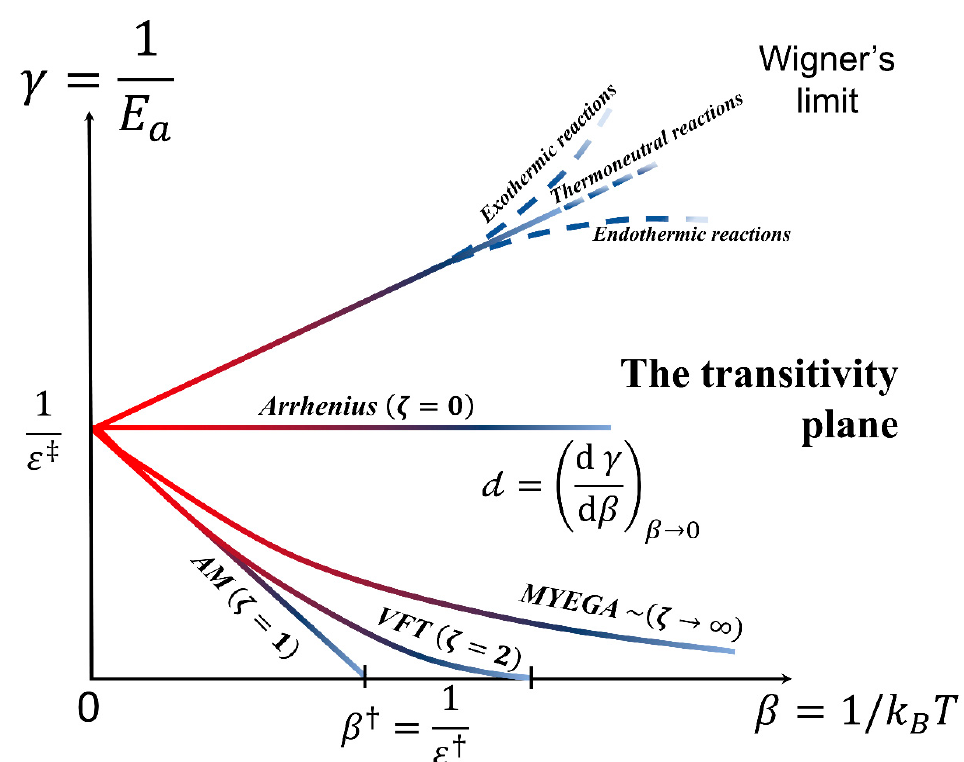
Figure 5. The alpha-zeta totem. The transitivity plane, introduced in [3], γ = 1/ E a vs . β = 1/ k B T serves to give a proper scaling to the phenomenological parameters occurring in the study of nonlinear Arrhenius plots. The Arrhenius behavior is given as corresponding to a line parallel to the β axis starting at 1/ ε ‡ . Deviations from the Arrhenius behavior give the transitivity function γ a straight-line at small β , which it is connected to the d parameter of the Aquilanti–Mundim (AM) law. At low temperatures, the transitivity function tends to characteristic ultra-cold limiting values: (i) for d < 0 ( sub -Arrhenius) it tends to the Wigner limit and (ii) for d > 0 ( super -Arrhenius), γ , namely the propensity for